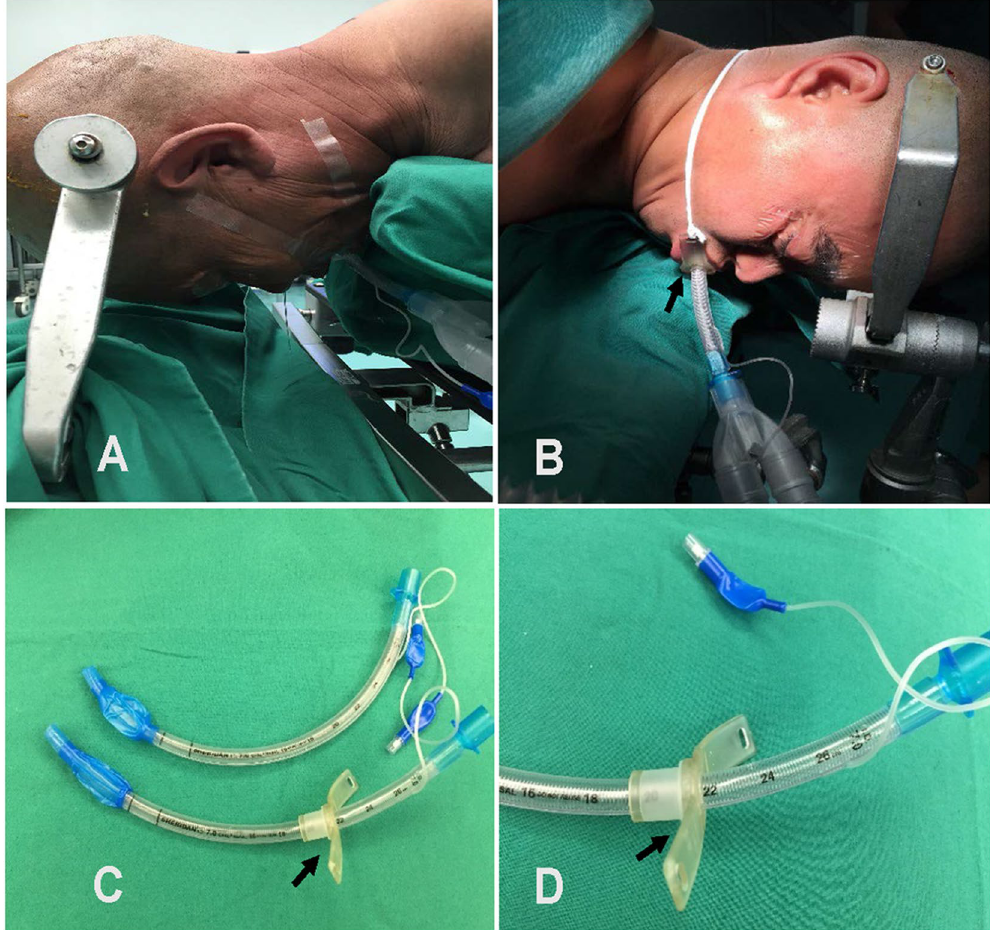
Figure 1. Photograph showing the traditional tube used in an operation ( A ) and the prone position tube used in an operation ( B ). The prone position tube (PPT) and the traditional tube (TT) ( C ). With a highlighted image of the prone position tube (PPT) ( D